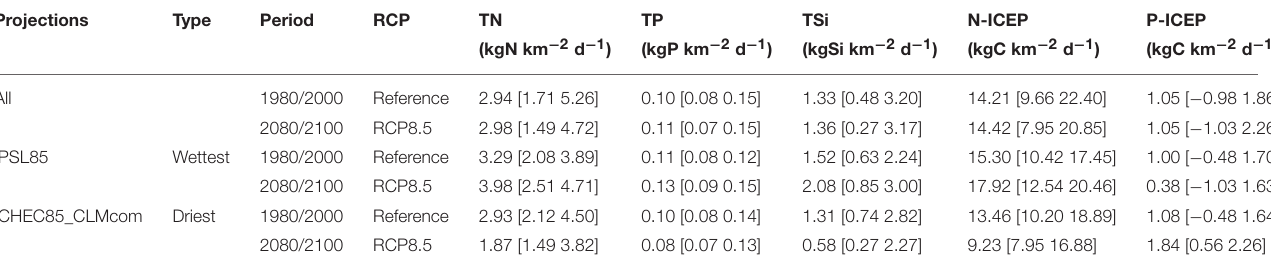
TABLE 2 | Annual median values for TN, TP and TSi fluxes, and indicators of coastal eutrophication potential (N-ICEP and P-ICEP), for all projections as well as for the wettest (IPSL85) and the driest (ICHEC85_CLMcom) projections. Projections